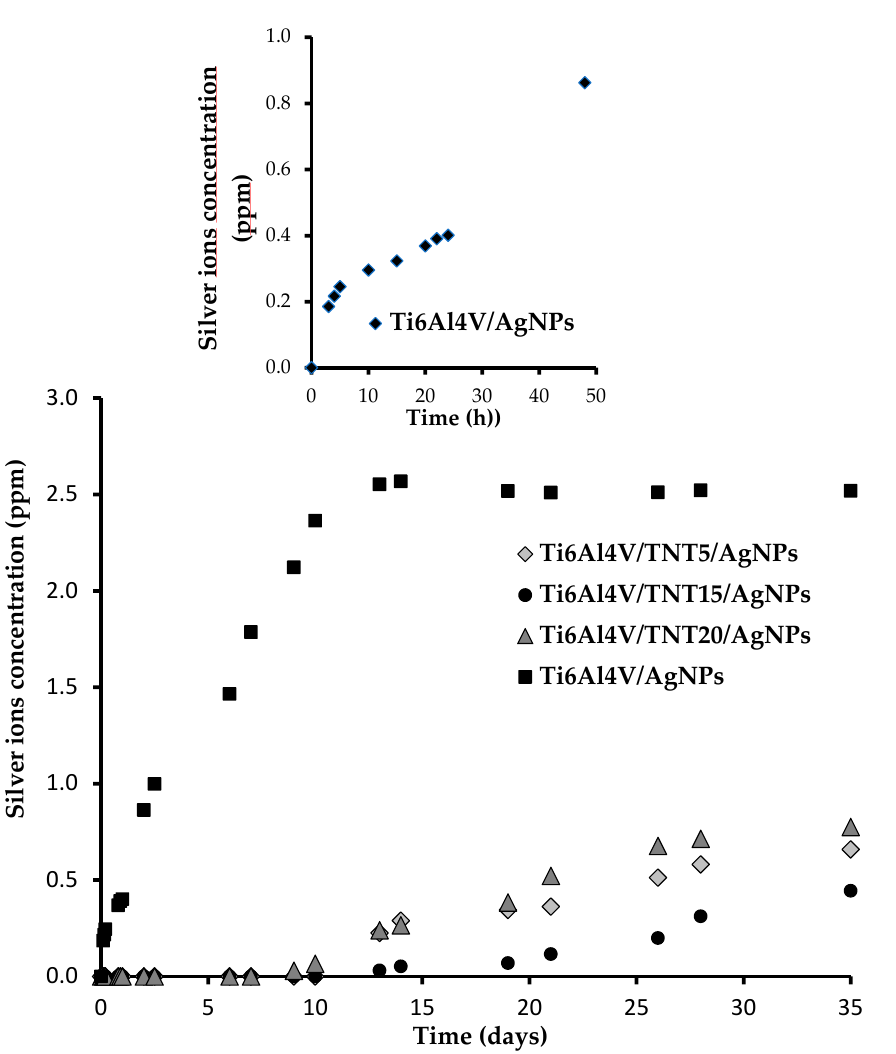
Figure 8. Silver ions released from Ti6Al4V/AgNPs coatings and Ti6Al4V/TNT5/AgNPs; Ti6Al4V/TNT15/AgNPs; and, Ti6Al4V/TNT20/AgNPs coatings immersed in phosphate buffered saline (PBS). The extracted graph shows the concentration changes of silver ions released from the surface of Ti6Al4V/AgNPs in the first 48 h after immersion off the sample in PBS solution.